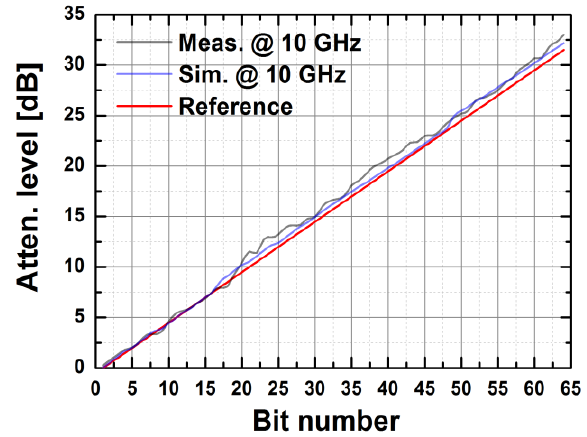
Figure 27. The measured attenuation levels vs. expected levels of the TRM at 10 GHz.